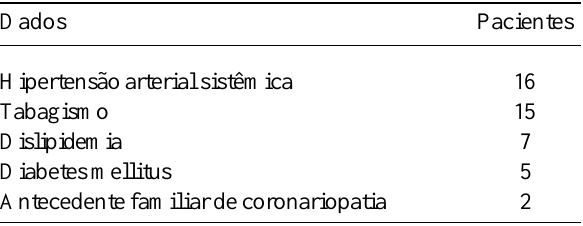
Tabela 2. Fatores de